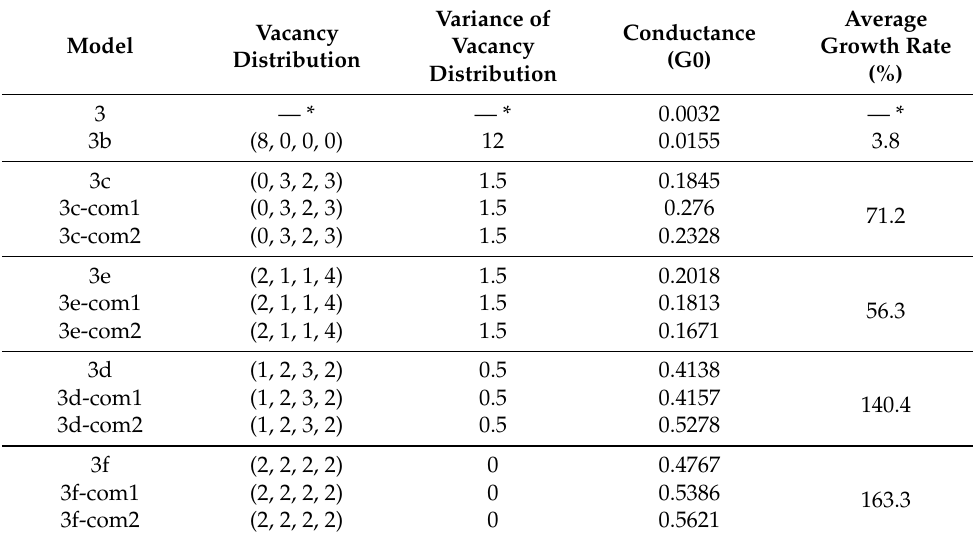
Table 2. Conductance comparison results of different vacancy